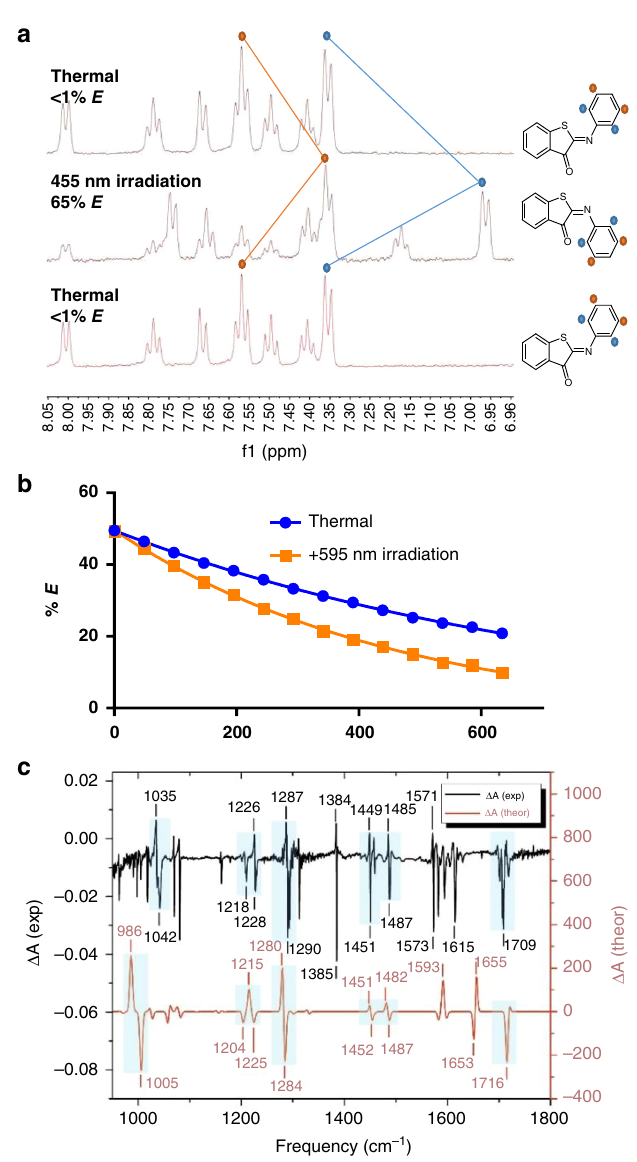
Fig. 3 NMR and IR spectroscopy. a NMR spectra of ITI 1a in CD 3 OD at − 60 o C for the thermally adapted, irradiated and again thermally adapted sample b: E - Z isomerization of ITI 1a at − 60 o C in CD 3 OD, recorded without (thermal) and with λ = 595nm irradiation (Supplementary Fig. 77, Supplementary Note 12) c E – Z FTIR difference spectrum recorded upon irradiation at 405nm in KBr at 184 K for ITI 1a . Comparison of experimental and theoretical IR difference spectra of 1a . Experimental FTIR difference spectrum of the compound 1a was obtained from the spectra in the dark and under 405nm light measured at 184 K in a KBr pellet (Supplementary Figs. 84 – 86). Simulated difference spectrum was obtained from scaled harmonic GS IR spectra (scaling factor f = 0.98) of the E - and Z -isomers of 1a in acetonitrile calculated with at the SMD-B3LYP/6- 31 ++ G(d,p) level. The experimental FTIR spectra are also reported in Supplementary Fig. 84 for better visualization. Further IR characterization can be found in Supplementary Notes 7,8, Supplementary Figs. 33 – 37